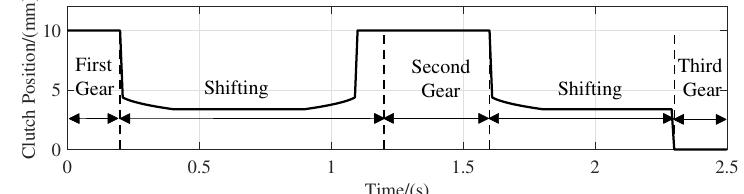
Figure 13. Reference displacement trajectory of the release bearing.